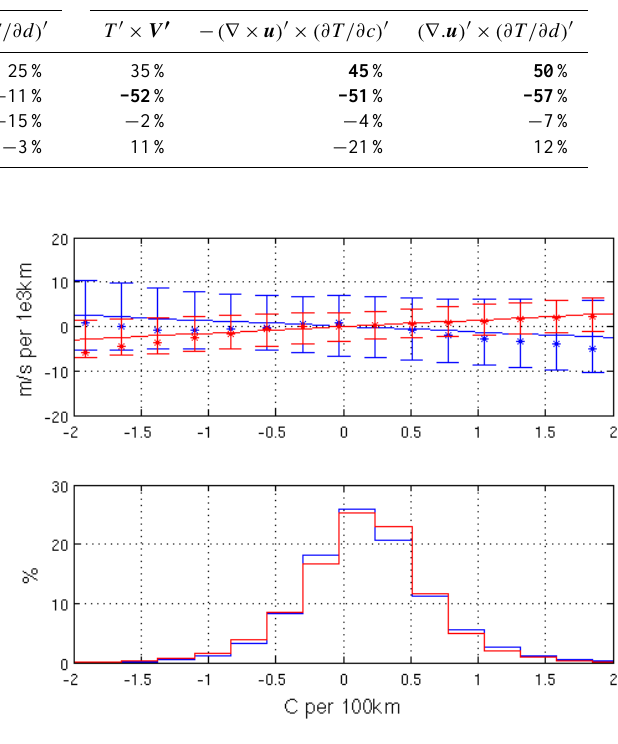
Figure 6. (a) ( ∇ . u ) 0 as color contours and (∂T/∂d) 0 as black contours – c.i. 1 × 10 − 7 ◦ C per 100km. (b) ( ∇ × u ) 0 (color contours) and (∂T/∂c) 0 (black contours – c.i. 1 × 10 − 7 ◦ C per 100km). The thick black lines represent the 0 ◦ C per 100km contours, the continuous lines positive values and the dashed lines negative values of T 0 gradient. The figures’ axes represent the distances from the eddy centers normalized by the eddy diameters. Table 1. Correlations between the slopes and correlation factors that indicate the air–sea coupling over the 16 Agulhas rings observed in the present study. The emphasized values correspond to the correlations statistically relevant to the 95% level. Slope